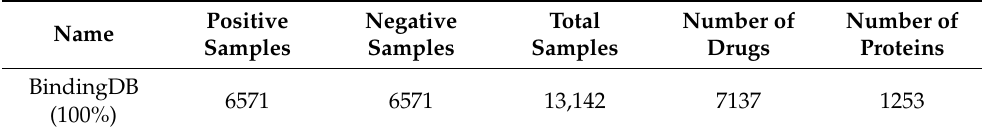
Table 1. BindingDB